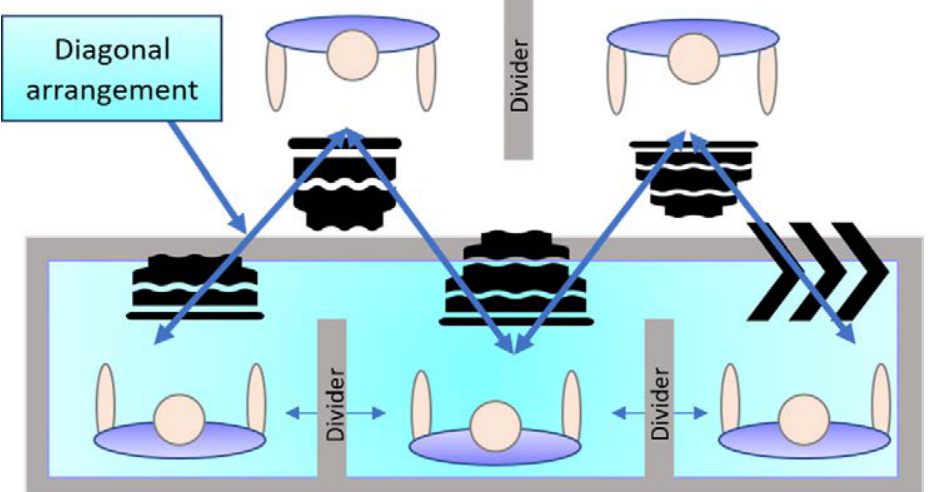
Fig. 2. The top view of a functional assembly line in the food processing industry and installation of dividers/barriers due to Covid-19 for two sides engagement of employees.